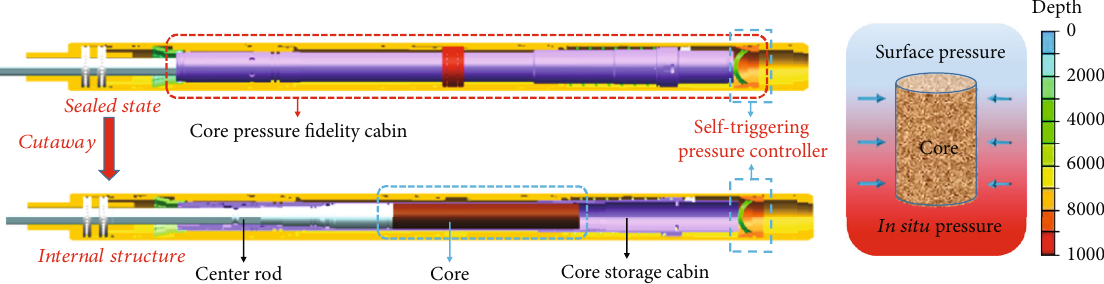
Figure 1: In situ pressure-maintaining coring of rock.